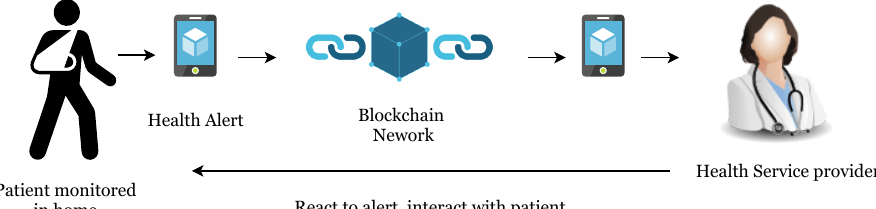
Figure 1. Remote Patient Monitoring.